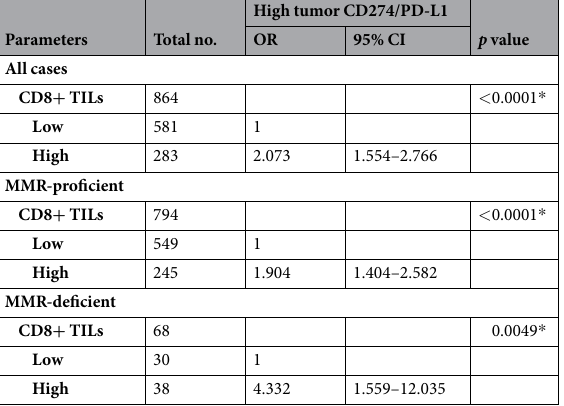
Table 2. Correlation between CD8 + TILs and tumor CD274/PD-L1 in stage II-III colon carcinoma patients (n = 864). * p < 0.005 is significant.